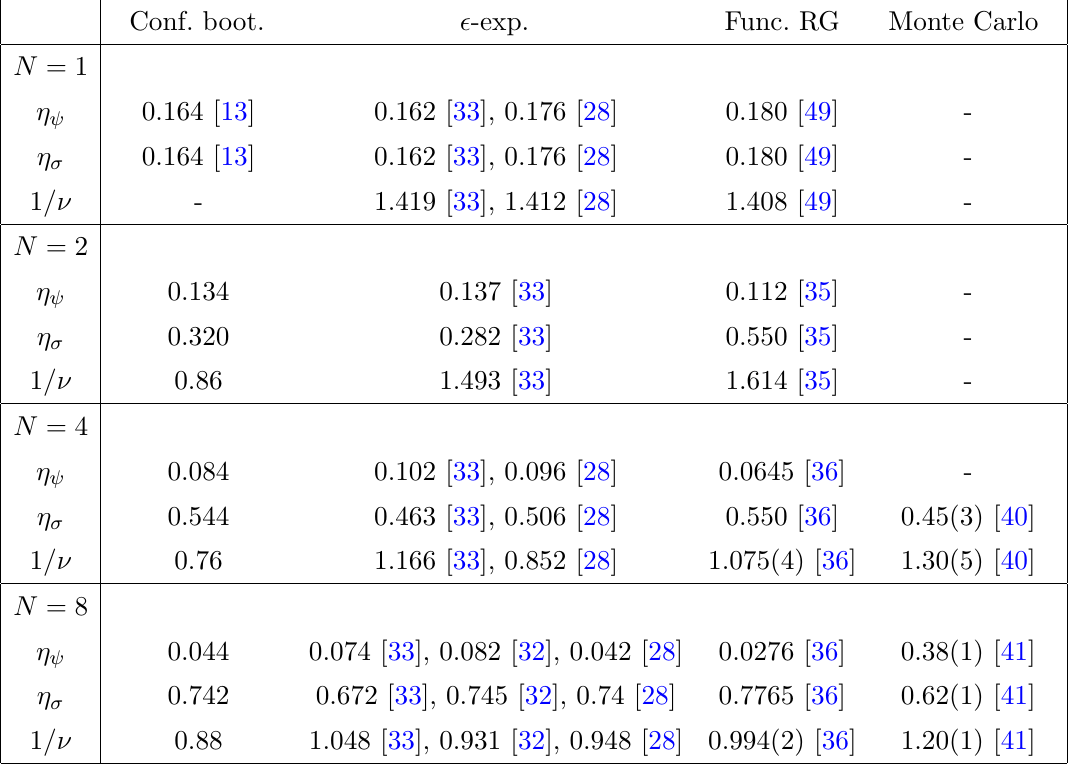
(cid:0) (cid:1) Table 3 . Anomalous dimensions, (cid:17) (cid:27) = 2 (cid:1) (cid:27) (cid:0) 1 and (cid:17) = 2((cid:1) (cid:0) 1), and correlation length 2 exponent, 1 =(cid:23) = 3 (cid:0) (cid:1) (cid:15) , for N = 1 ; 2 ; 4 ; 8. Conformal bootstrap results for N = 1 are taken from our previous work in [13] by intersecting the curve of kink found by imposing a gap on the dimension (cid:1) (cid:27) 0 with the SUSY line (cid:1) = (cid:1) (cid:27) +1 = 2. The bootstrap results for 1 =(cid:23) are obtained from estimating (cid:1) (cid:15) using the extremal functional method. The results shown from [33] for the